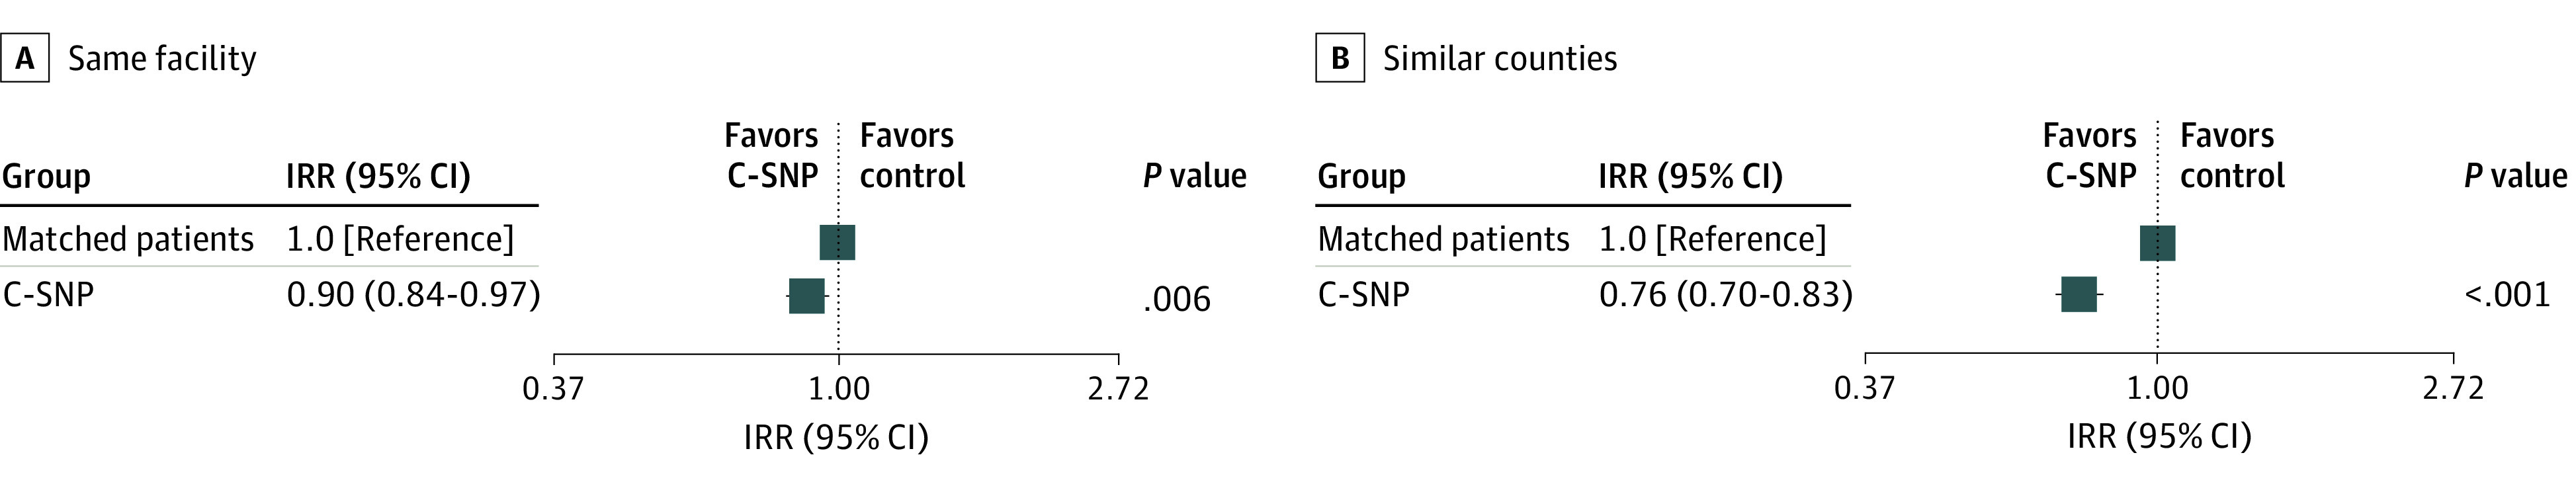
Hospitalizations Among Chronic Condition Special Needs Plan (C-SNP) Enrollees and Matched Patients Across Same Facility and Similar Counties IRR indicates incidence rate ratio.